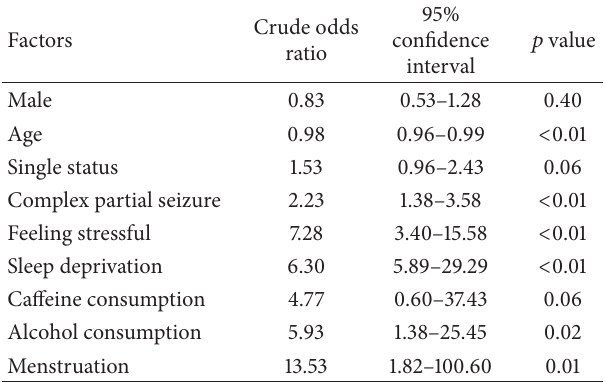
Table 2: Univariate analysis of factors for seizure attack in persons with epilepsy.